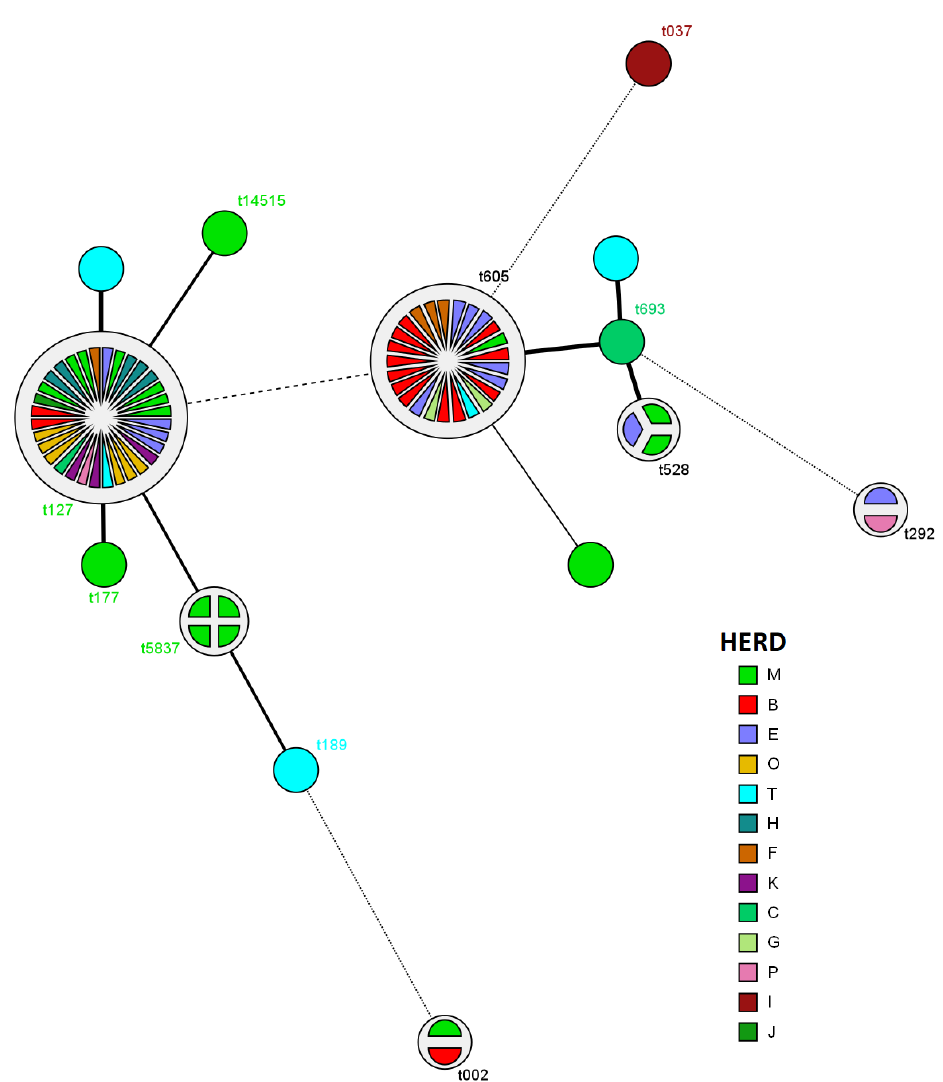
Figure 2. Minimum spanning tree (MST) showing 76 Staphylococcus aureus isolates recovered from affected mammary quarters of cows with clinical mastitis and genotyped using the spa-typing method. Each node represents one spa-type, and the corresponding spa-type is given beside the node. The distribution of spa-types within herds are represented by colors. Lengths ≤ 1 are represented by dotted lines while lengths >1 by solid lines. Three isolates did not have spa-type recognized by the molecular method.